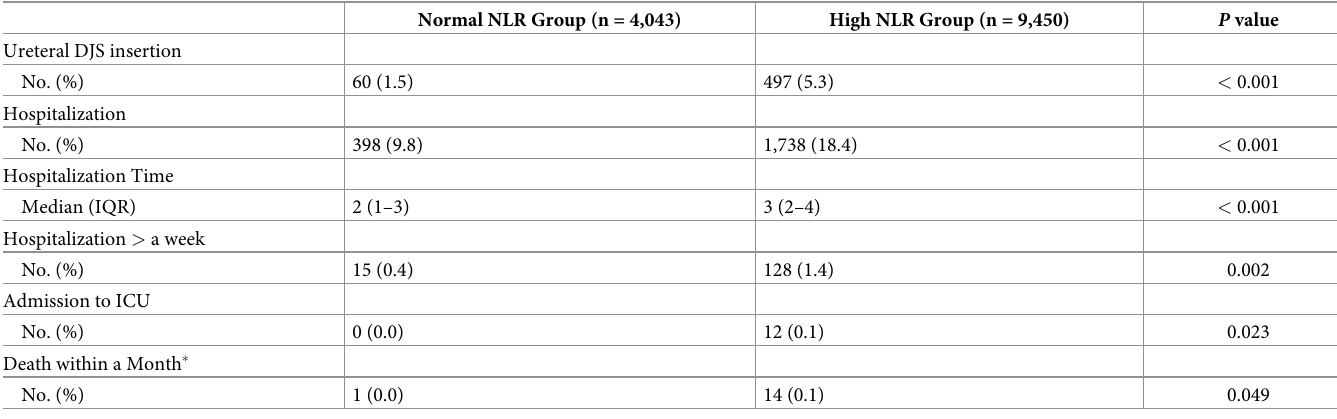
Table 2. Clinical